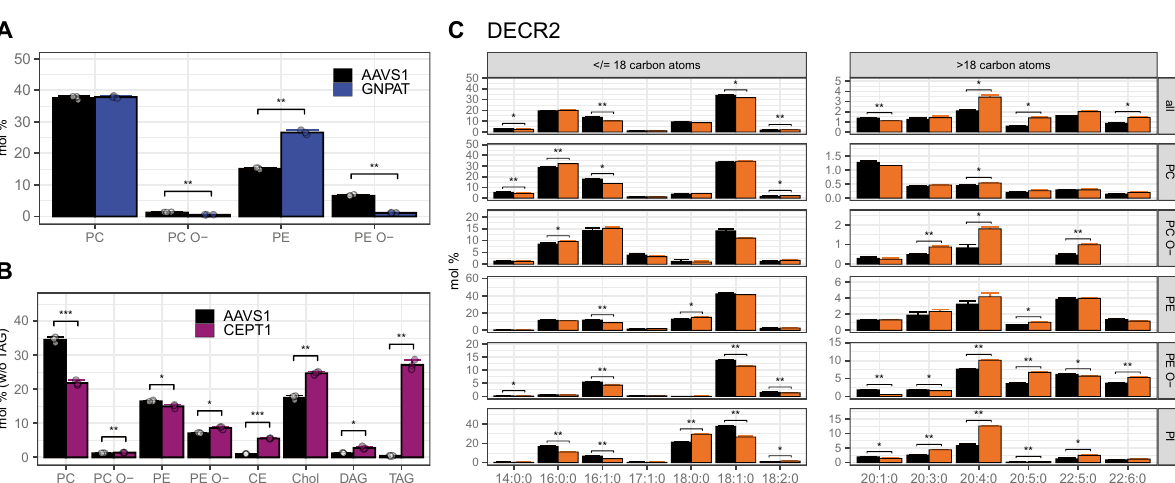
Figure 5. Genes in GP metabolism compared to AAVS1 control. ( A ) GNPAT KO—GP classes with choline and ethanolamine head groups: Diacyl (PC, PE) and ether-linked (PE O-, PC O-) lipid classes are shown. See details in Suppl. Figure S03 ( B ) CEPT1 KO—Lipid classes: Due to the strong differences in TAG levels, all lipids are standardized to the total lipid content without TAG. The CEPT1 KO clone B8 is displayed, which was created by the deletion method. See details Suppl. Figure S05. ( C ) DECR2 KO—DECR2 knockout: Lipid species of the DECR2 KO cell line (n = 3) and the AAVS1 control (n = 3) were compared. Fatty acid profile: greater than 1 mol% across CE, DAG, LPC, LPE, LPE O-, LPG, LPI, PA, PC, PC O-, PE, PE O-, PG, PI, PS, TAG lipid classes and individual profiles of PC, PC O-, PE, PE O-, PI. Means are indicated by bar plots. Error bars correspond